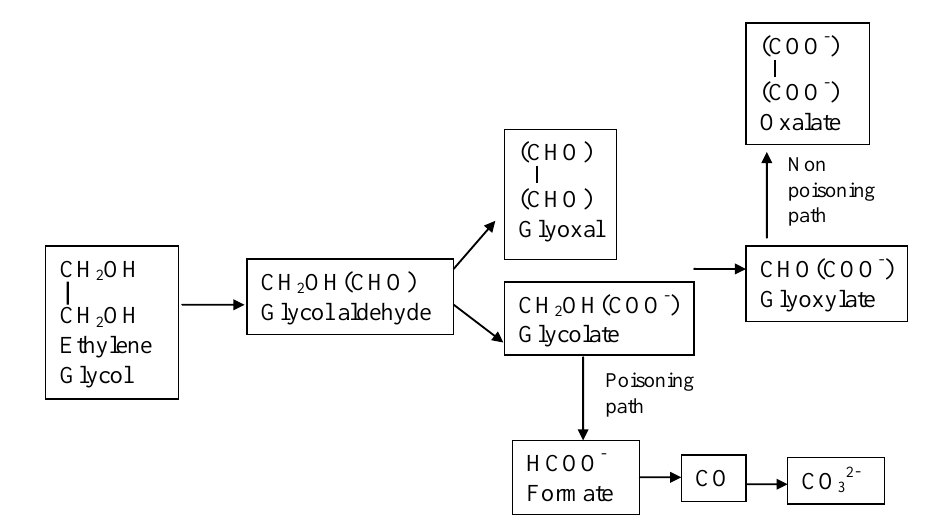
Figure 2. Reaction pathways of ethylene glycol electrochemical oxidation in alkaline media